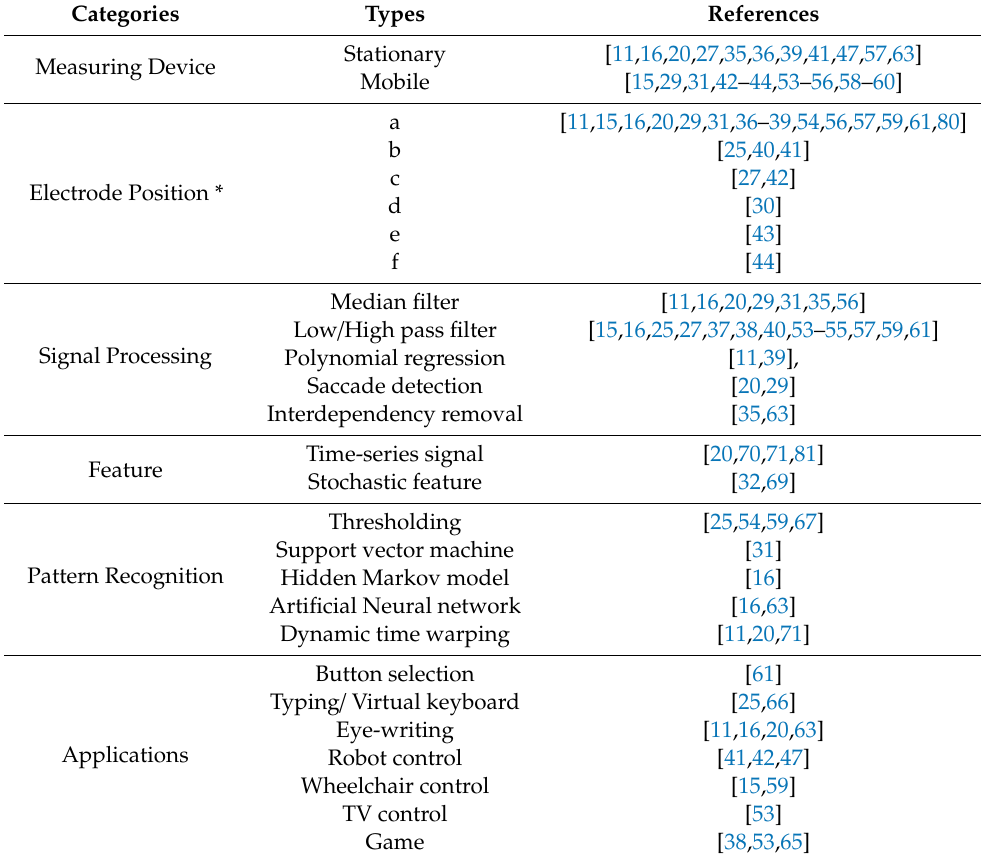
Table 1. Summary of recent studies on EOGs for human computer